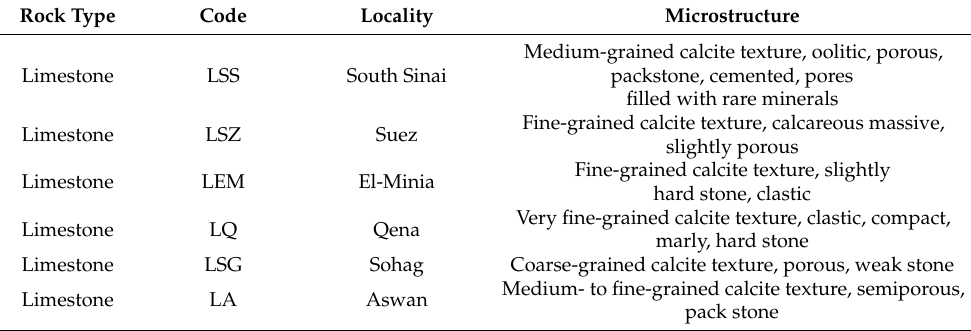
Table 1. Petrographic features of the tested limestone